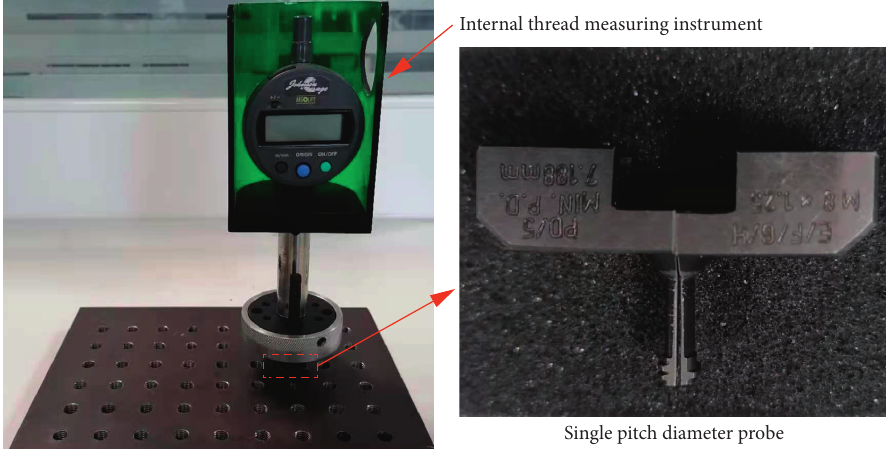
Figure 3: GJ-5S internal thread measuring instrument.